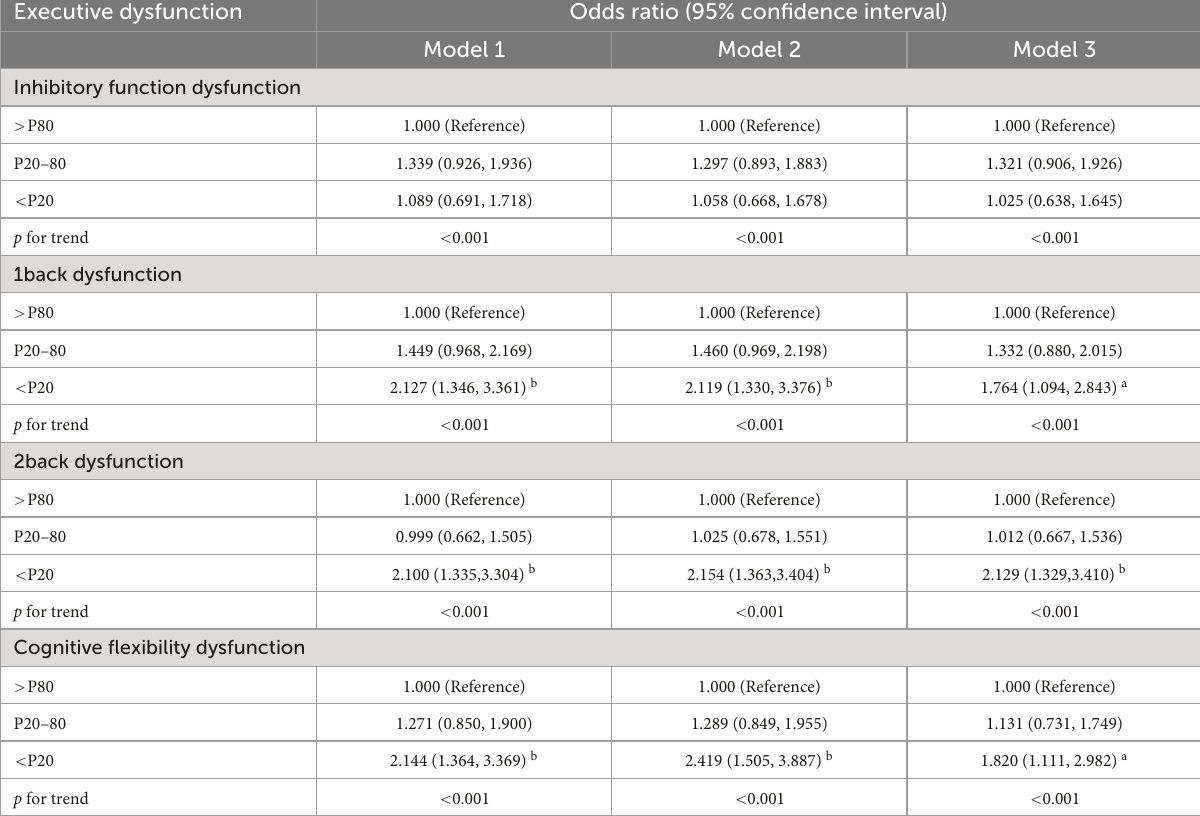
TABLE 4 Logistic regression analysis of muscle strength index and executive function in children and adolescents in rural areas of China ( n =